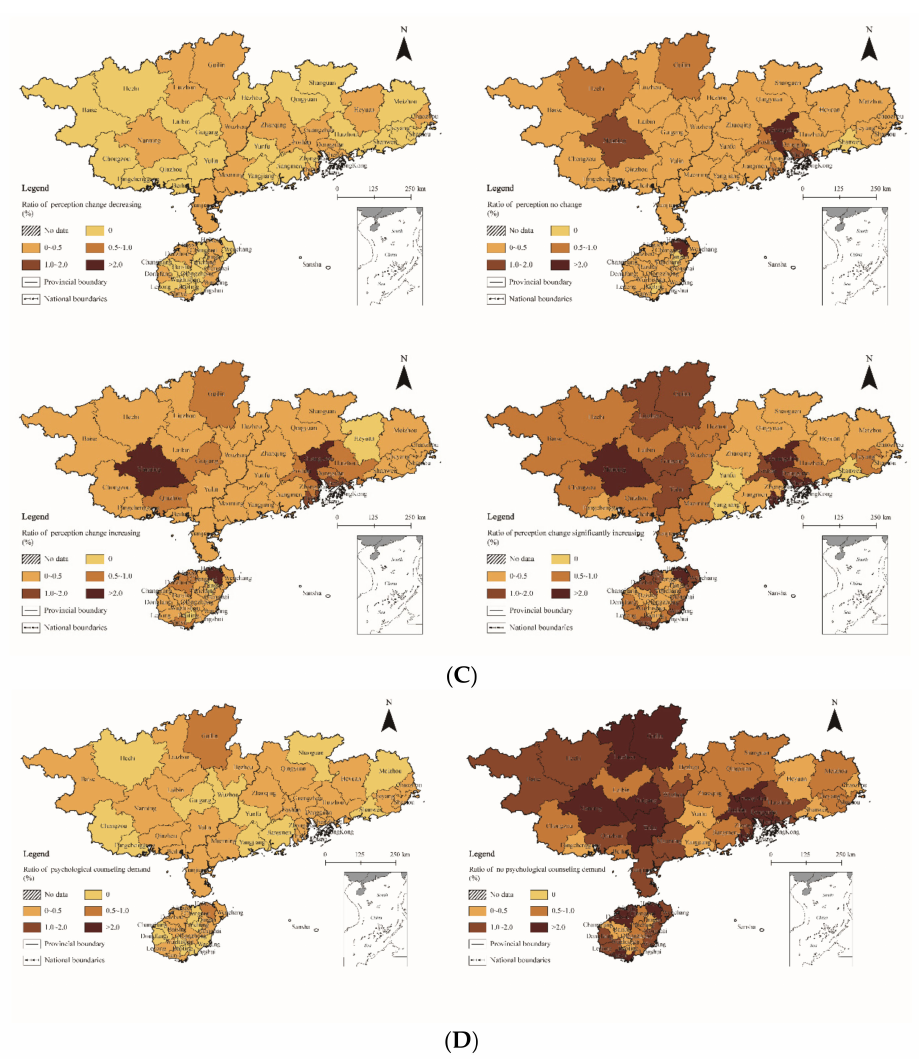
Figure 3. Spatial distribution of psychological status ratios. ( A ) Negative emotion (Q1); ( B ) Psycho- logical stress (Q2); ( C ) Perception change (Q3); ( D ) Psychological crisis